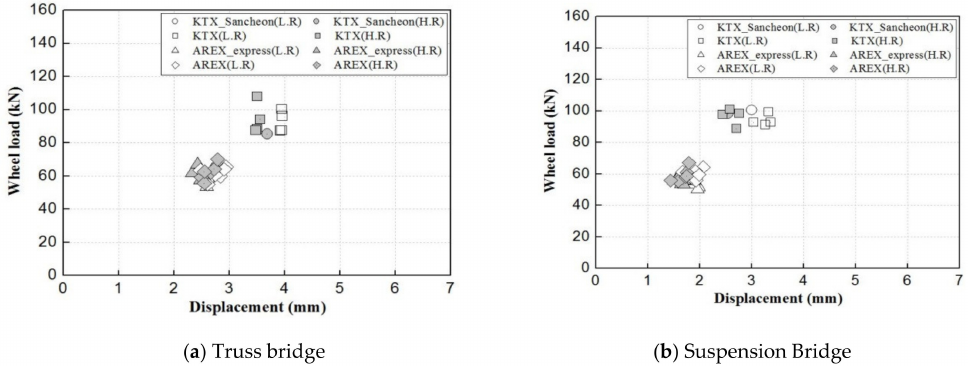
Figure 14. Result of internal and external load-displacement according to train